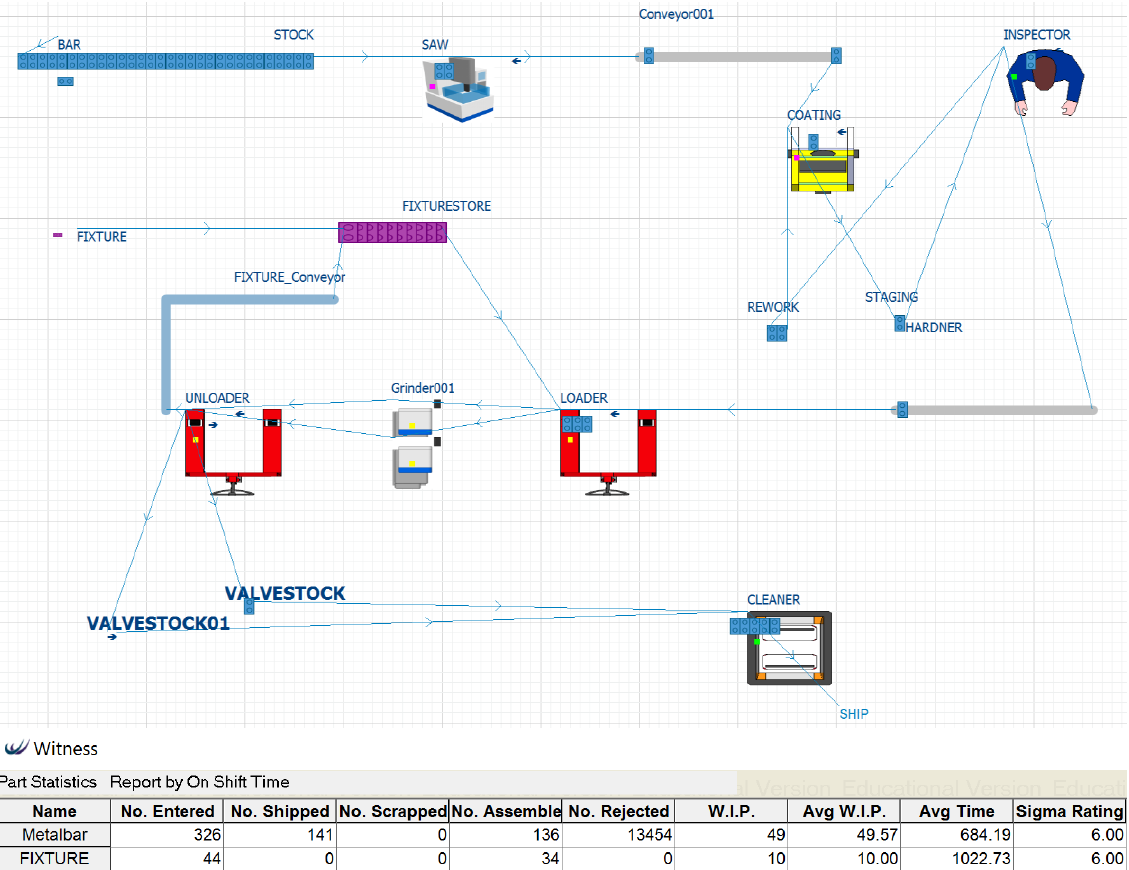
Figure 11. Valve manufacturing process mapping.